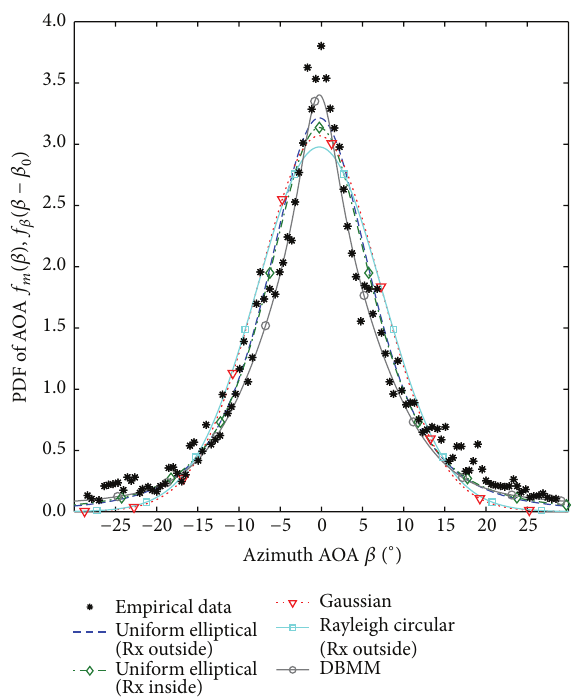
Figure 11: Fitting for various geometric models to the empirical data in Pedersen et al. [1, Figure 4 ],